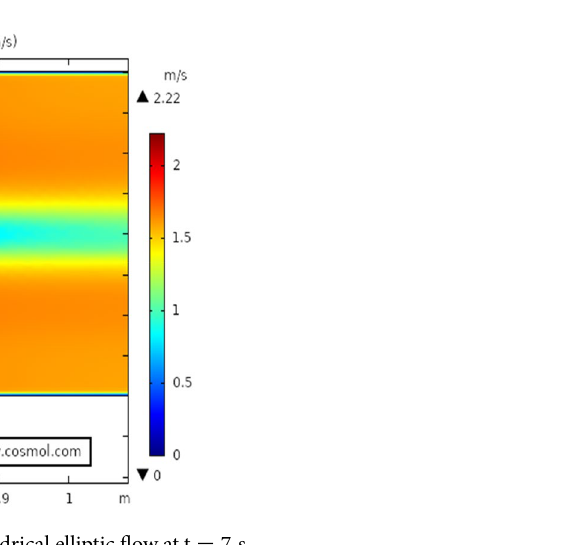
Figure 3. The velocity distribution in cylindrical elliptic flow at t = 7 s